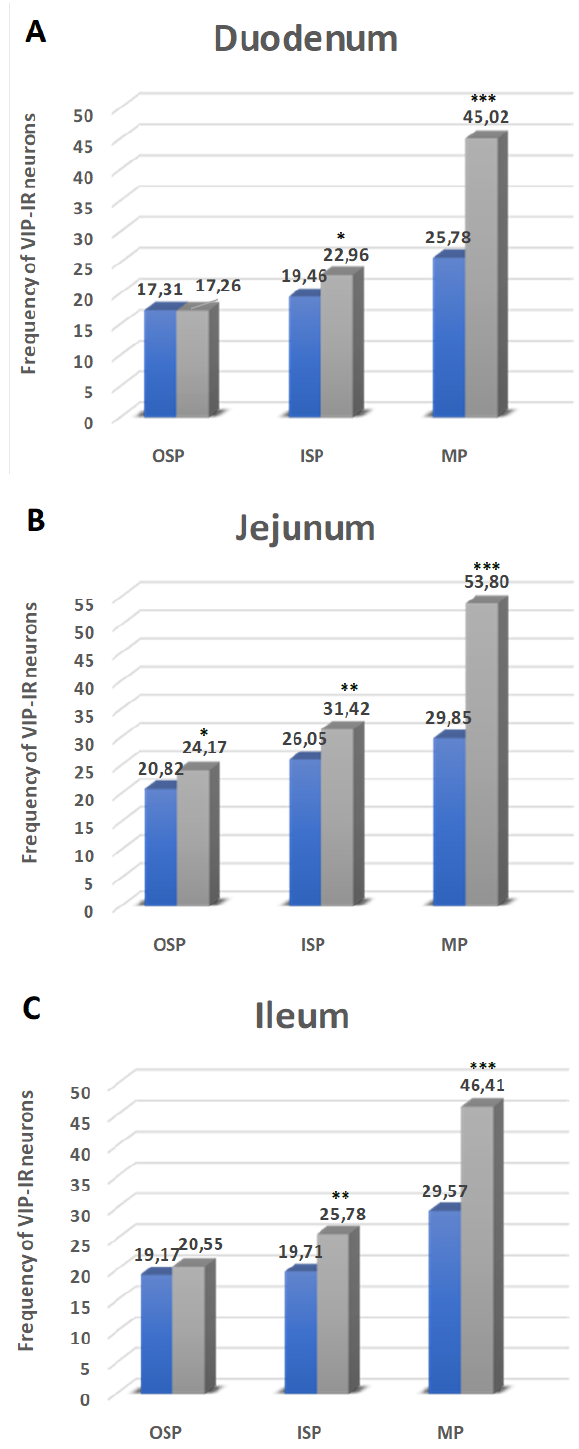
Figure 5. Schematic diagram of the numbers of perikarya immunoreactive to a vasoactive intestinal polypeptide (VIP) ( A–C ) of the control (blue bars) and experimental group (grey bars) in the particular parts of the small intestine. OSP – outer submucosal plexus, ISP – inner submucosal plexus, MP – myenteric plexus. * p < 0.05, ** p < 0.01, *** p < 0.001 – indicate differences between all groups for the same neuronal populations.